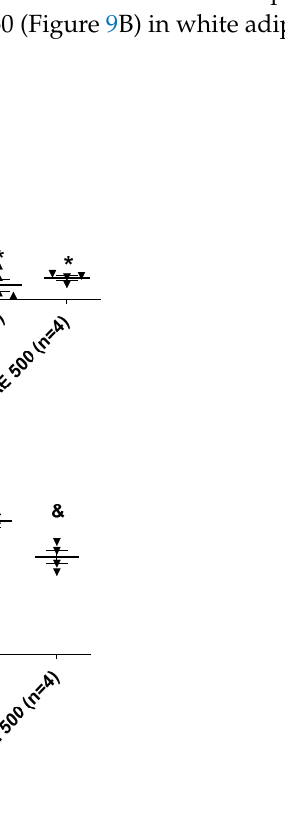
Figure 9. Effects of the HFF diet and M. citrifolia (noni) aqueous extract (AE) in the mRNA content of metabolic genes in the epididymal fat and liver. ( A ) Peroxisome proliferator-activated receptor- γ (PPAR- γ ) in epididymal adipose tissue; ( B ) peroxisome proliferator-activated receptor- α (PPAR- α ) in epididymal adipose tissue; ( C ) peroxisome proliferator-activated receptor- γ (PPAR- γ ) in the liver; ( D ) peroxisome proliferator-activated receptor- α (PPAR- α ) in the liver of full black circle: CTW (CT + drinking water), full black quadrilateral: HFFW (high-fat / high-fructose diet + drinking water); black up-pointing triangle: HFF + AE 250 (HFF + M. citrifolia fruit aqueous extract of 250 mg / kg); and black down-pointing triangle: HFF + AE 500 (HFF + M. citrifolia fruit aqueous extract of 500 mg / kg) groups. The results are expressed as the mean ± SEM. * = p ≤ 0.05 vs. CTW; & = p ≤ 0.05 vs. HFFW; # = p ≤ 0.05 vs. HFF + AE 250. ANOVA followed by the Tukey post-test.